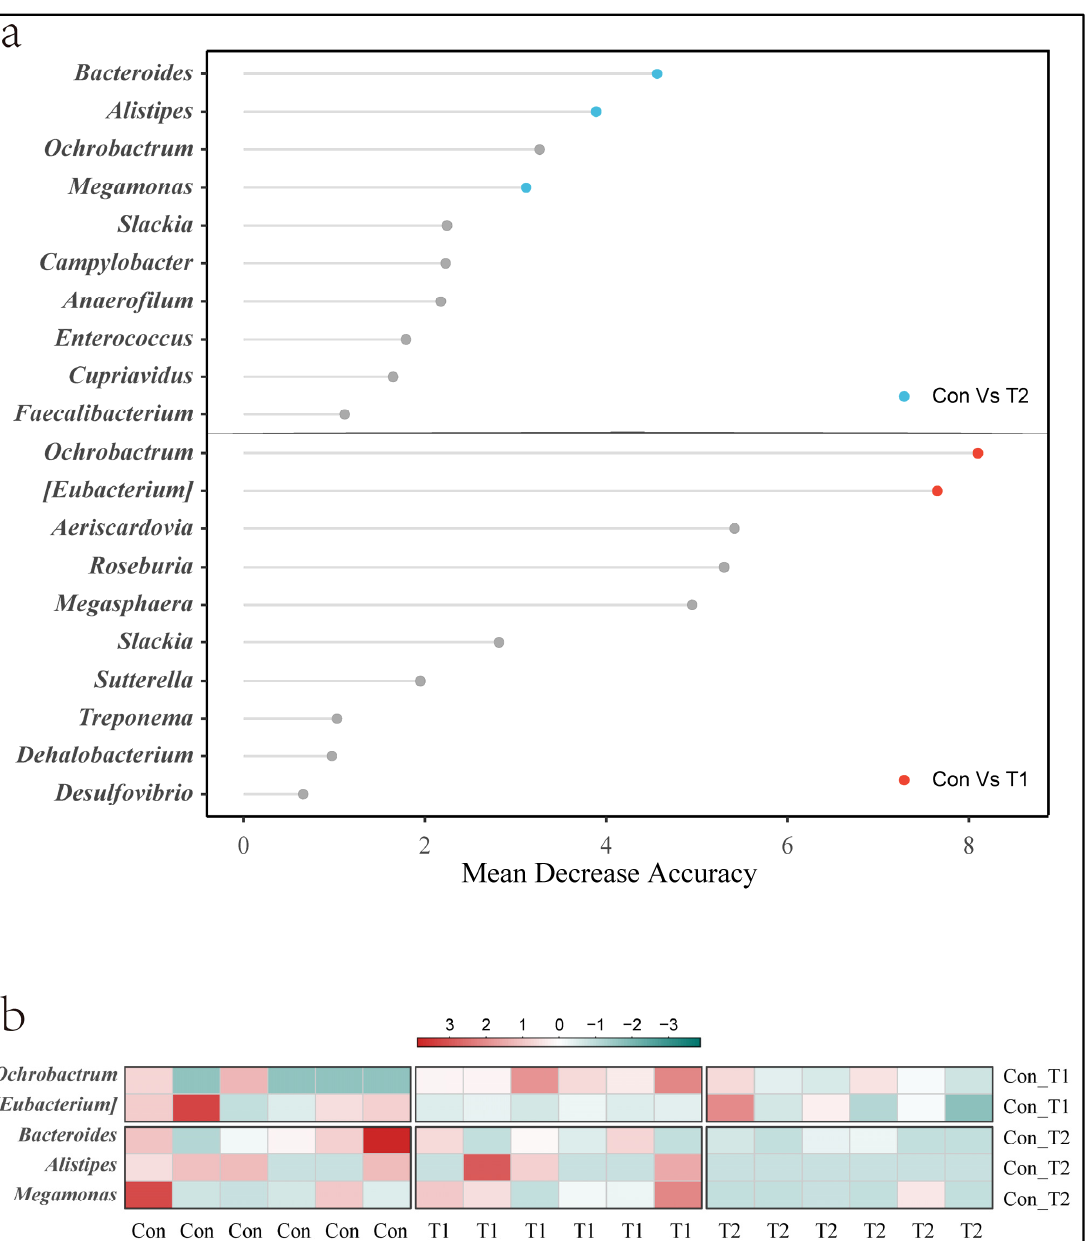
Figure 4. The machine-learning classification based on genera in cecal microbial using random forest algorithms. ( a ) The top 10 genera according to relative importance by the mean decrease accuracy of “Con vs. T1” and “Con vs. T2” (the number of permutations was 1000 times). The red circle represents the genera that were confirmed and p < 0.05 simultaneously in “Con vs. T1”. The blue circle represents the genera that were confirmed and p < 0.05 simultaneously in “Con vs. T2”. ( b ) The heat map of the relative abundance of the genera identified through random forest .